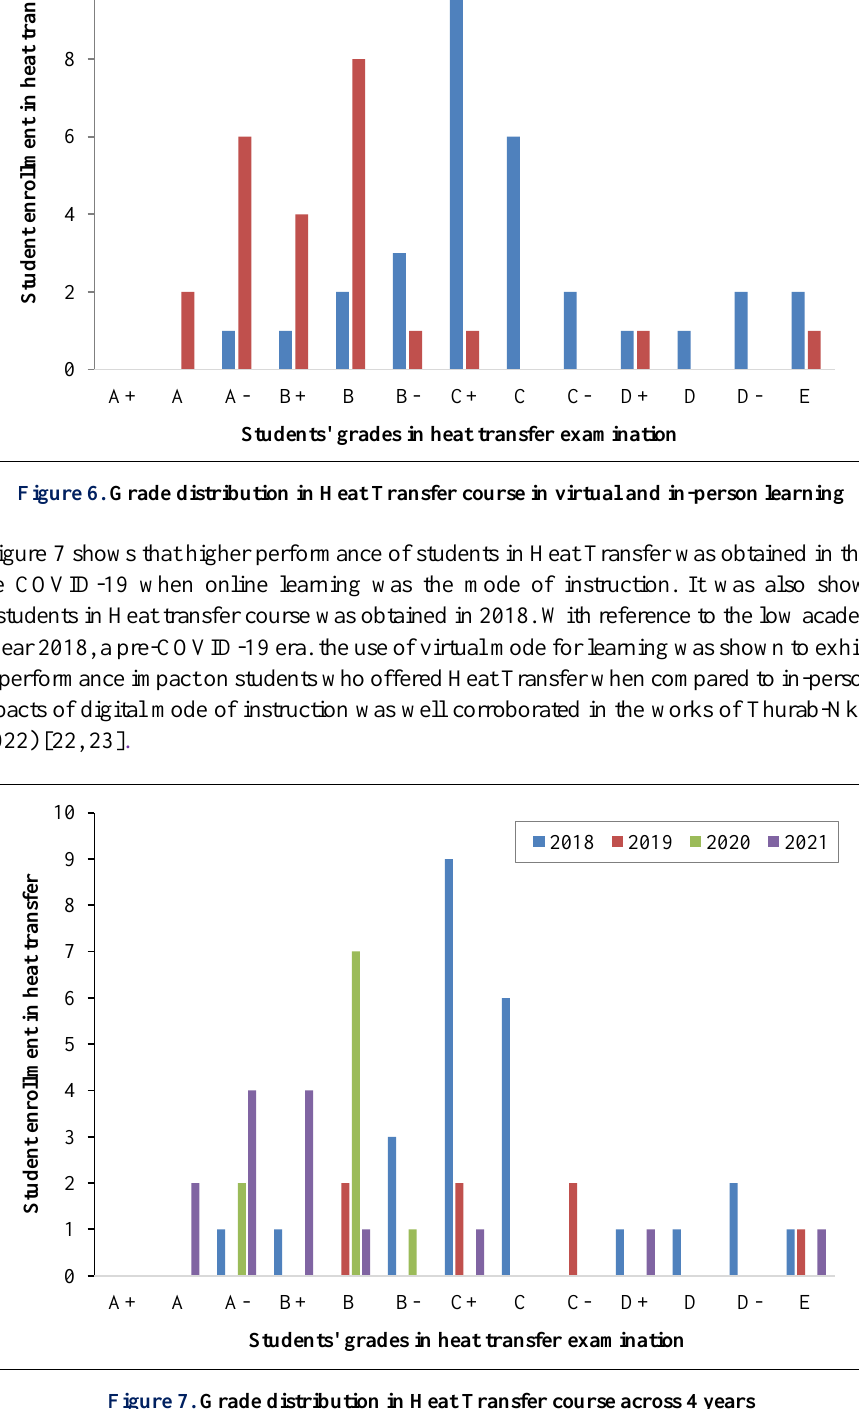
Figure 7. Grade distribution in Heat Transfer course across 4 years RQ4: Does mode of instruction significantly influence academic performance of engineering students in Advanced